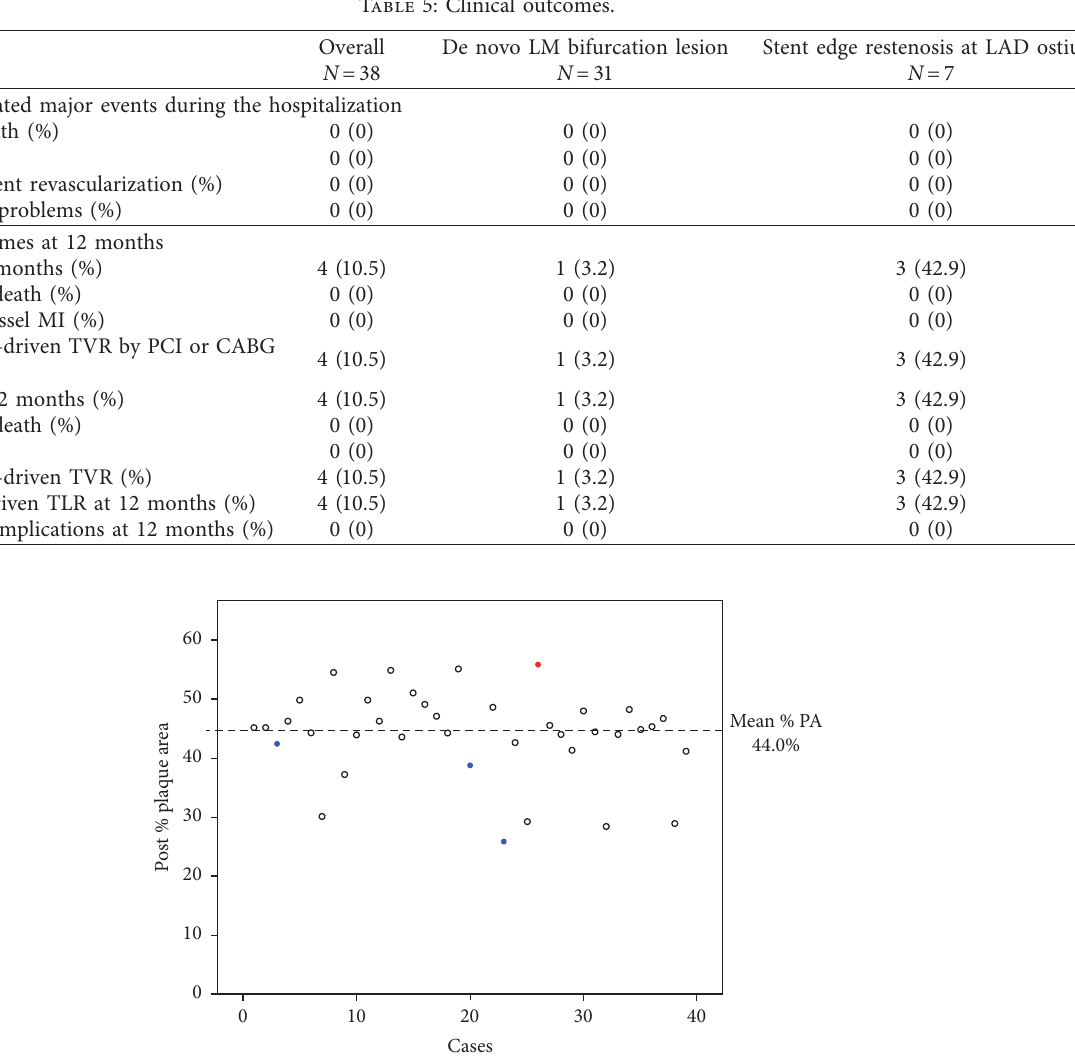
Figure 1: Distribution of % PA after DCA for each case. Mean %PA in the overall population was 44.0%. The red dot shows ischemia-driven TLR case at 12 months for the de novo LM bifurcation lesion after DCA. The blue dots show ischemia-driven TLR cases at 12 months for stent edge restenosis at the LAD ostium after DCA.